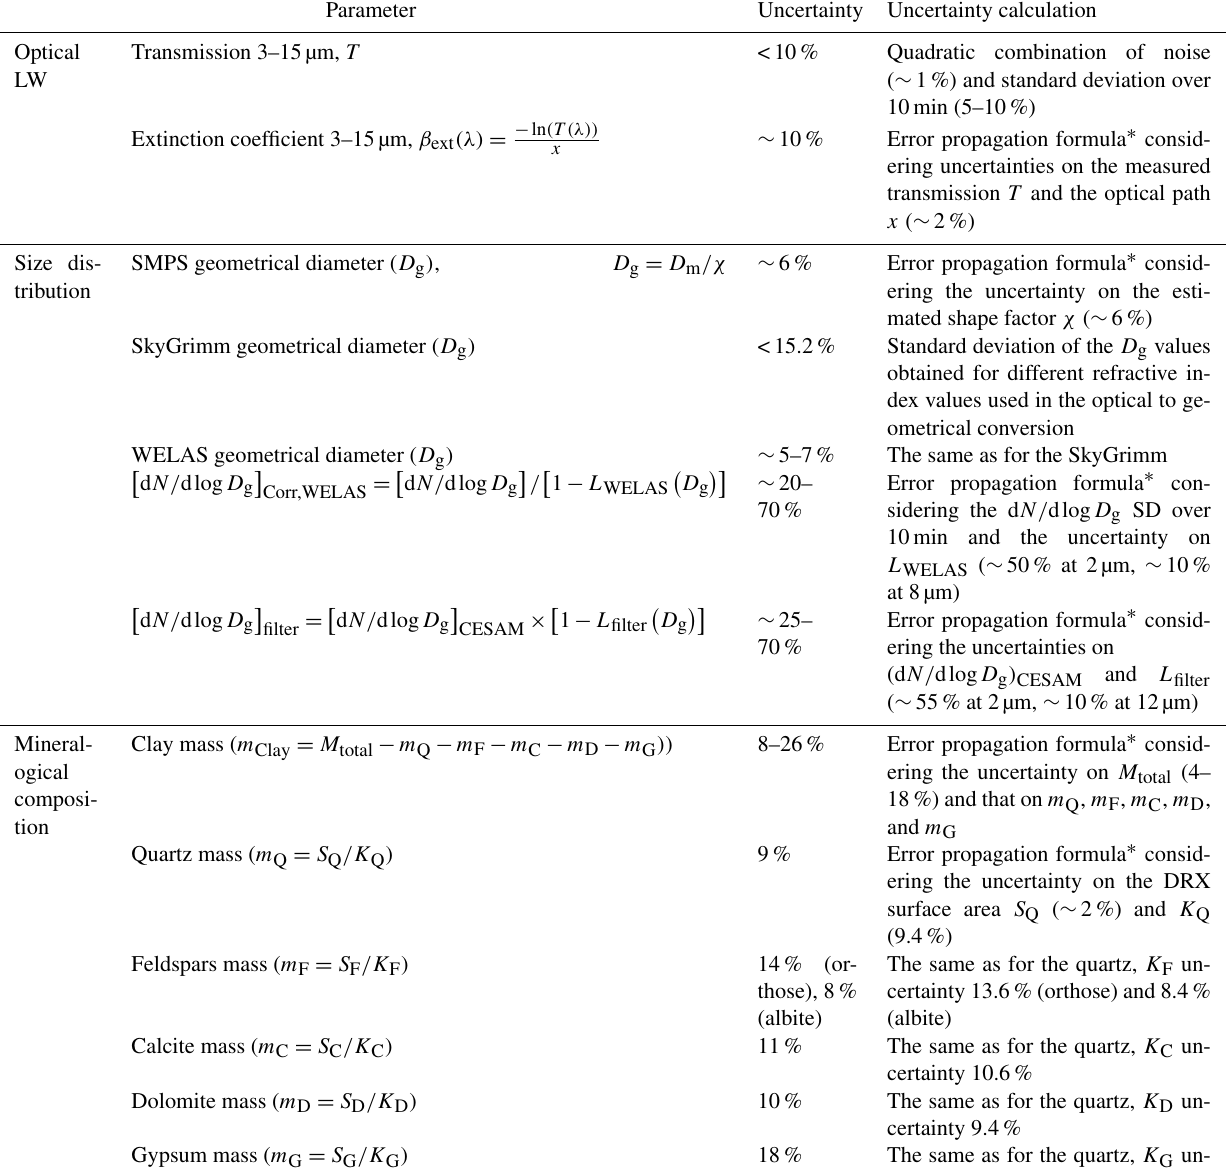
Table 1. Measured and retrieved quantities and their estimated uncertainties. For further details refer to Sect. 2.